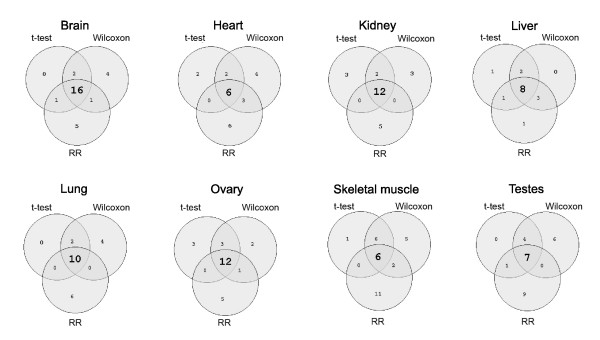
Overlap between three methods of detecting miRNA signatures on mRNA expression profiles. Results from eight tissues are presented in separate Venn diagrams. Each circle in the Venn diagrams indicates the number of miRNAs with significantly low target gene expression as predicted by the t-test, Wilcoxon or RR methods. For all tissues there was significant overlap amongst predicted miRNAs, with the Wilcoxon rank sum test and absolute expression t-test in strongest agreement. The numbers of miRNAs predicted by all three methods are indicated in bold.